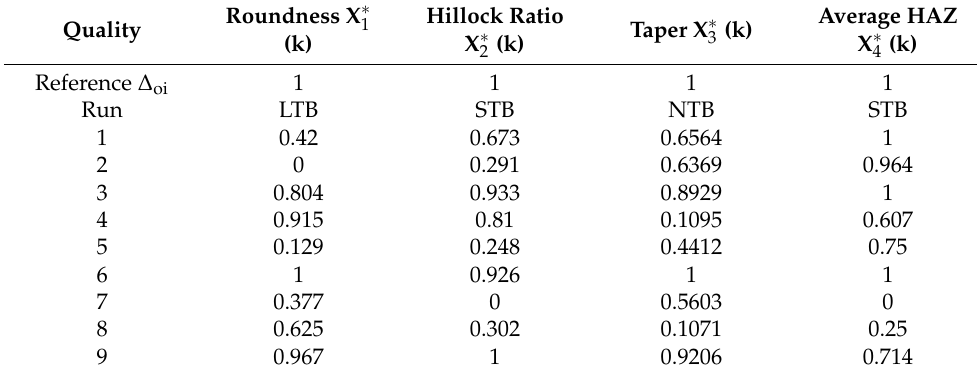
Table 5. Grey relational generation of multiple qualities.